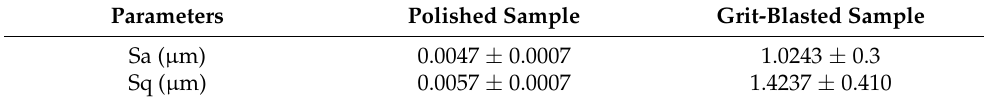
Figure 3. Surface 3D morphology of the substrates subjected to ( a ) polishing and ( b ) grit blasting. Table 4. Surface roughness of the samples subjected to the polishing and grit-blasting pretreatment.